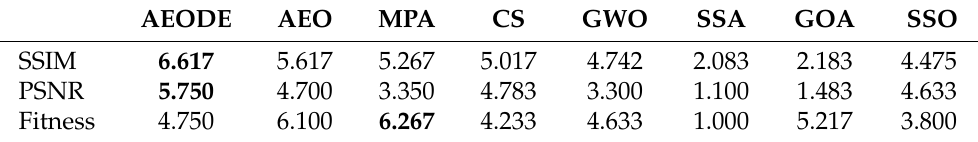
Table 5. Results of the Friedman test for all measures (bold means the best